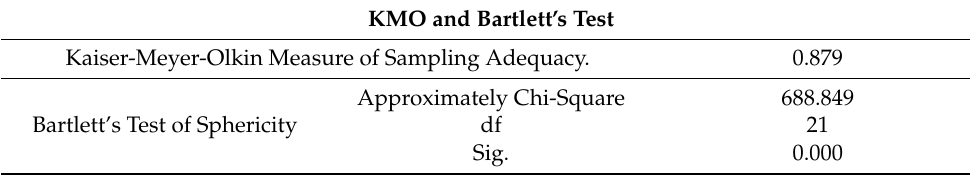
Table 6. KMO and Bartlett’s test (dependent variables).